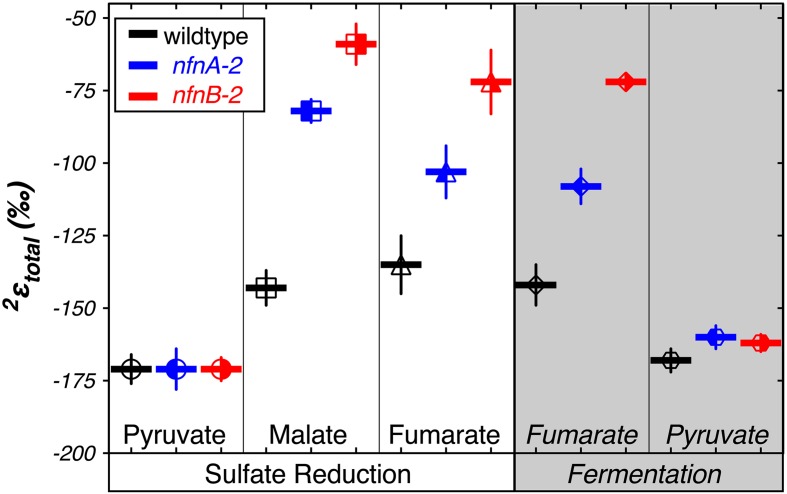
Hydrogen isotope fractionation between media water and the mass-weighted lipid pool (2εtotal) is plotted for each treat. Vertical bars are standard errors on the mean (SEM). Symbols and colors are consistent with Figures 2 and 3.